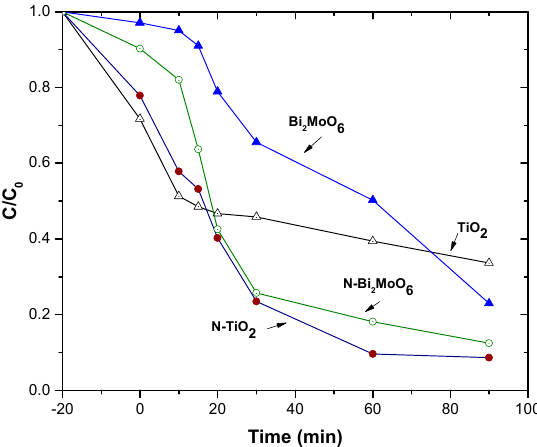
Figure 7. Methylene blue degradation in presence of TiO 2 , N-TiO 2 , Bi 2 MoO 6 , and N-Bi 2 MoO 6 catalysts under visible light (VIS) energy irradiation.